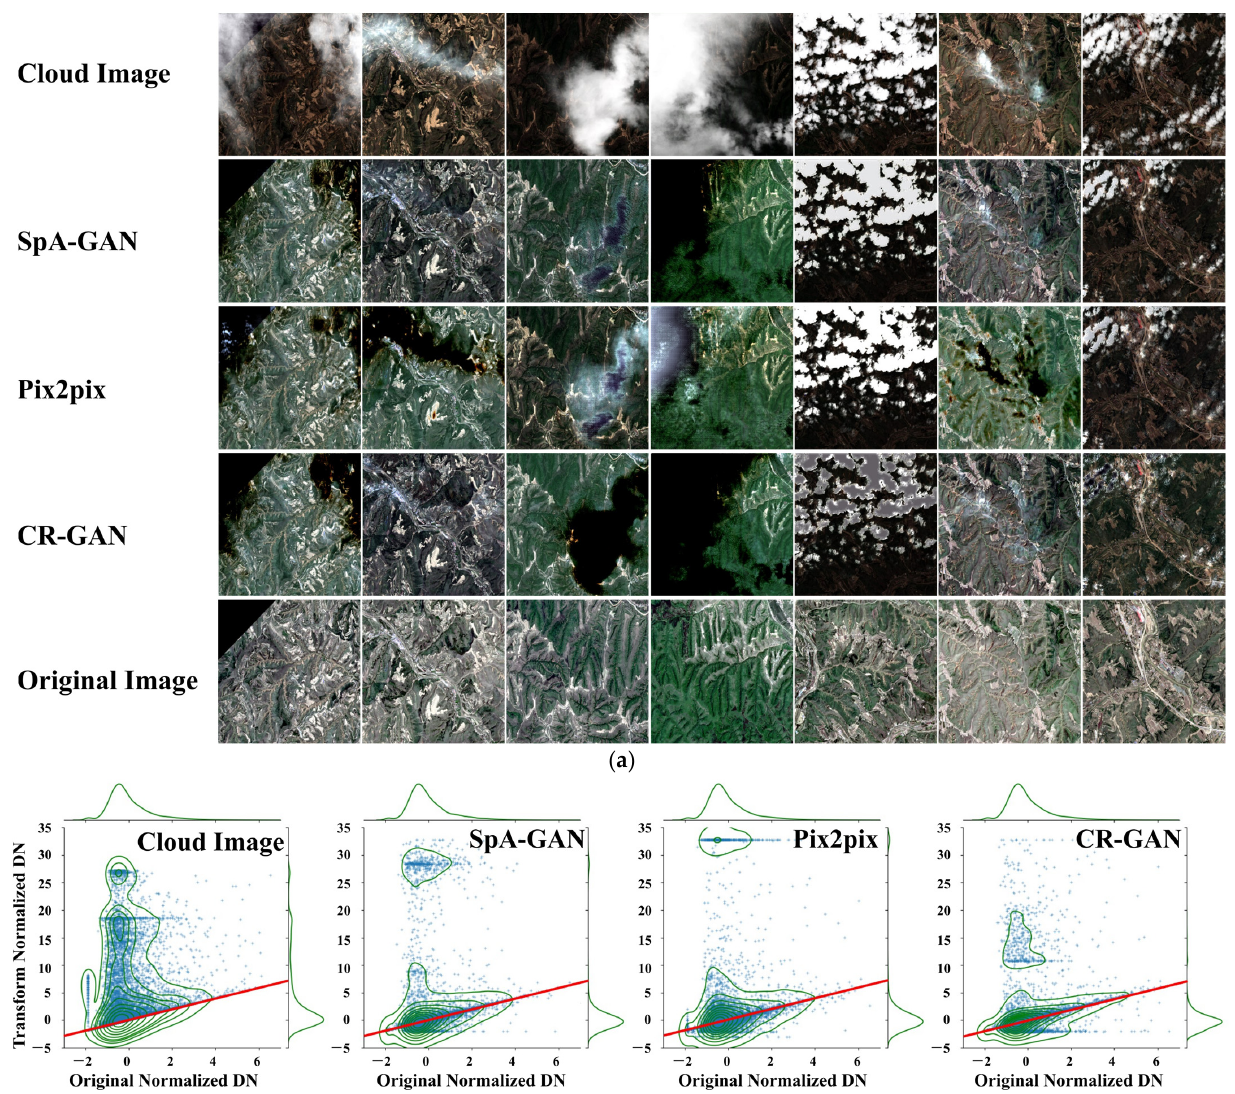
Figure A3. ( a ) CGANs after changing the conditions. ( b ) Cloud removal results from various methods, and cloud-free images are compared for pixel distribution characteristics. We first use normalization to convert the image to a normal distribution, and then we randomly sample the distribution of 100,000 points statistics in the normalized image due to the wide range of data distribution. The red line represents the best estimate; points below are considered overcorrected, and those above are considered undercorrected. The green curve represents the probability density of the scattered points.